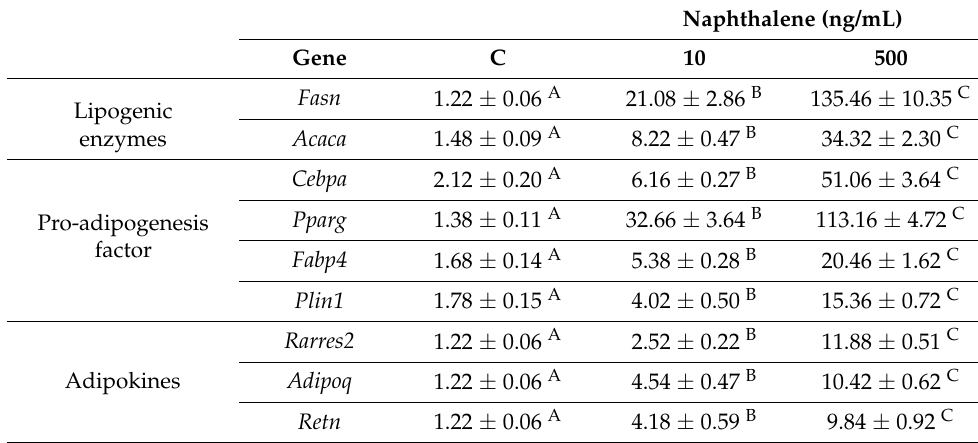
Figure 3. Effect of naphthalene on 3T3-L1 cell differentiation. ( A ): Representative picture of 3T3-L1 cells in response to naphtalene (10 and 500 ng/mL) after 7 days of differentiation stained with Oil Red O. ( B ): The values were normalized to the average of control group levels. Results are expressed as mean ± SEM ( n = 6) from three independent experiments. **** p < 0.0001. Table 7. Effect of naphthalene on gene expression of factors involved in adipogenesis and lipogenesis in 3T3-L1 cells. Values are expressed as mean ± SEM ( n = 3), p ≤ 0.05; different capital letters indicate a significant difference between control and different concentrations of naphthalene.